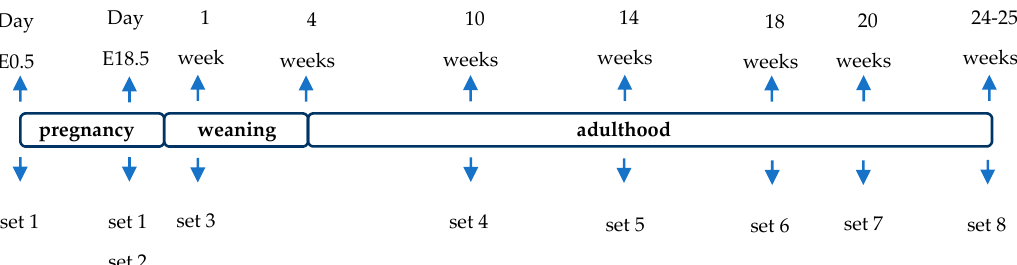
Scheme 1. Schematic representation indicating the set of animals studied over time. Set 1 = pregnant mice; Set 2 = E18.5 fetuses; Set 3 = pups (1 week old); Set 4 = 10-weeks-old mice; Set 5 = 14-weeks-old mice; Set 6 = 18-weeks-old mice; Set 7 = 20-weeks-old mice and Set 8 = 24/25-weeks-old mice.